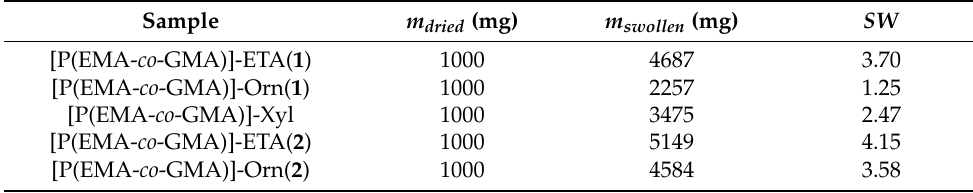
Table 2. Water uptake of the modified [P(EMA)- co -(GMA)] and their derivatives.